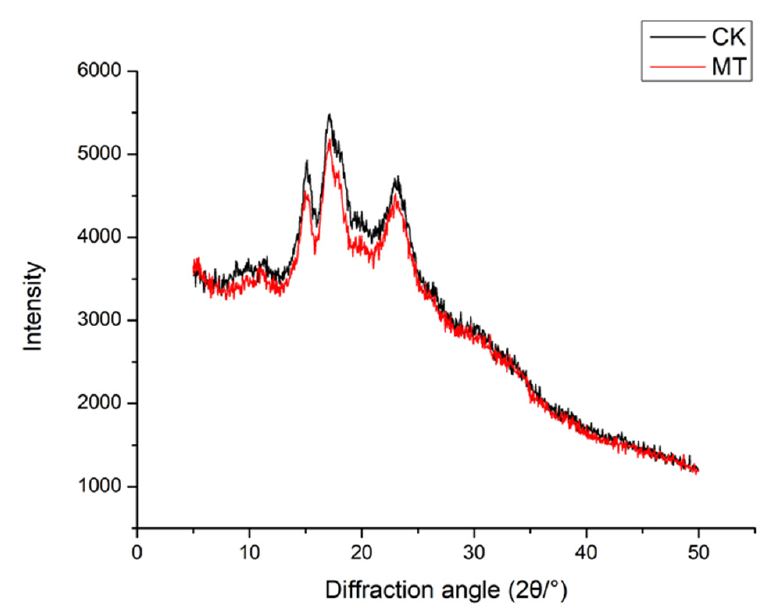
Figure 6. X-ray diffraction patterns of pre-cooked microwave adzuki beans starch samples as com- pared to untreated adzuki beans.